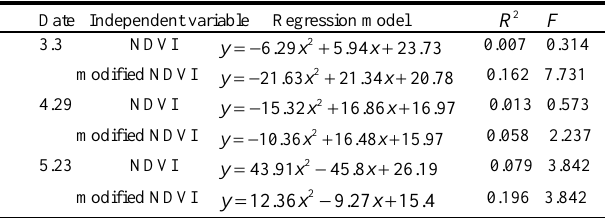
Table 4. 10cm soil moisture regression model in northern